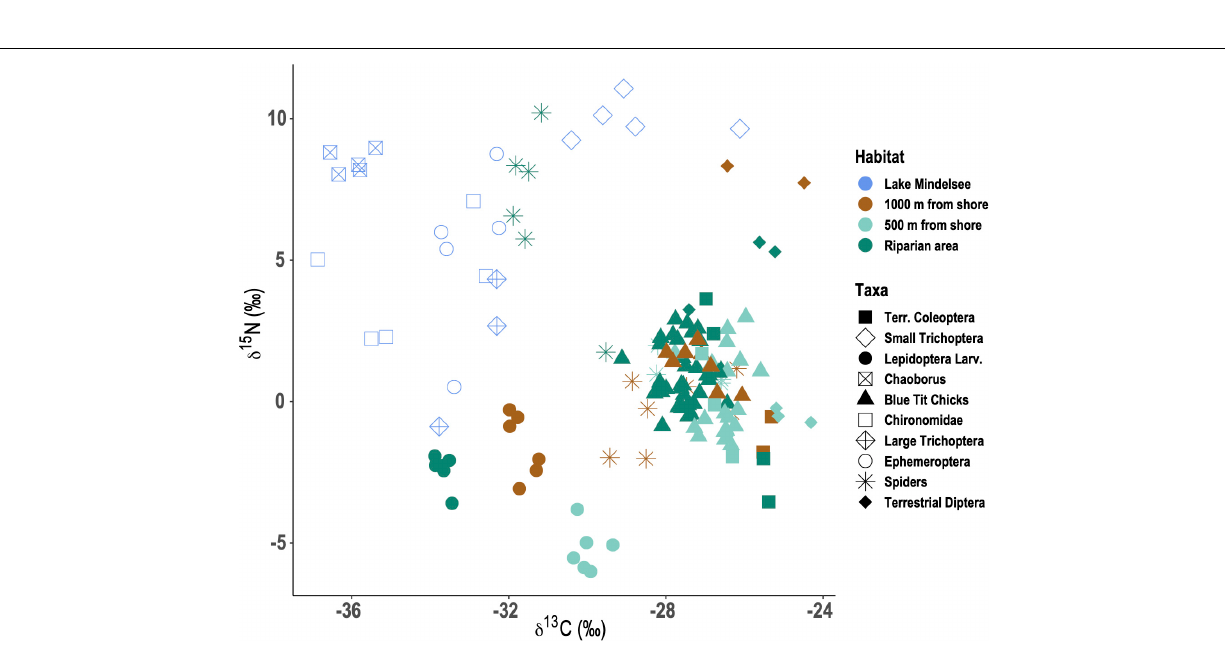
Frontiers in Ecology and Evolution |